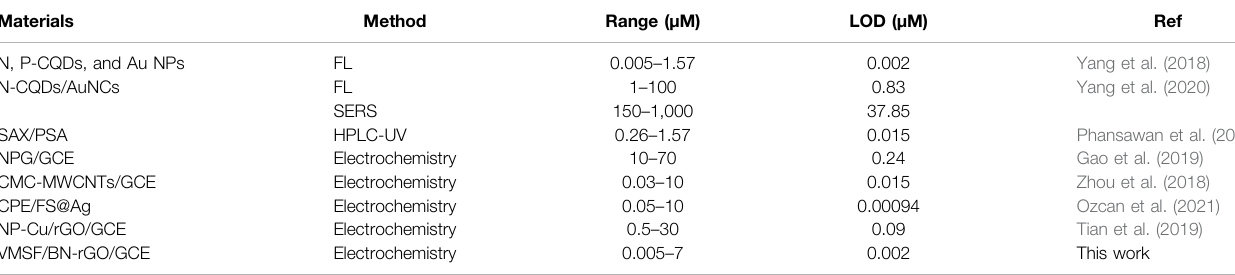
TABLE 1 | Comparison of the analytical performances of various analytical methods for the determination of CBZ. Materials Method N, P-CQDs, and Au